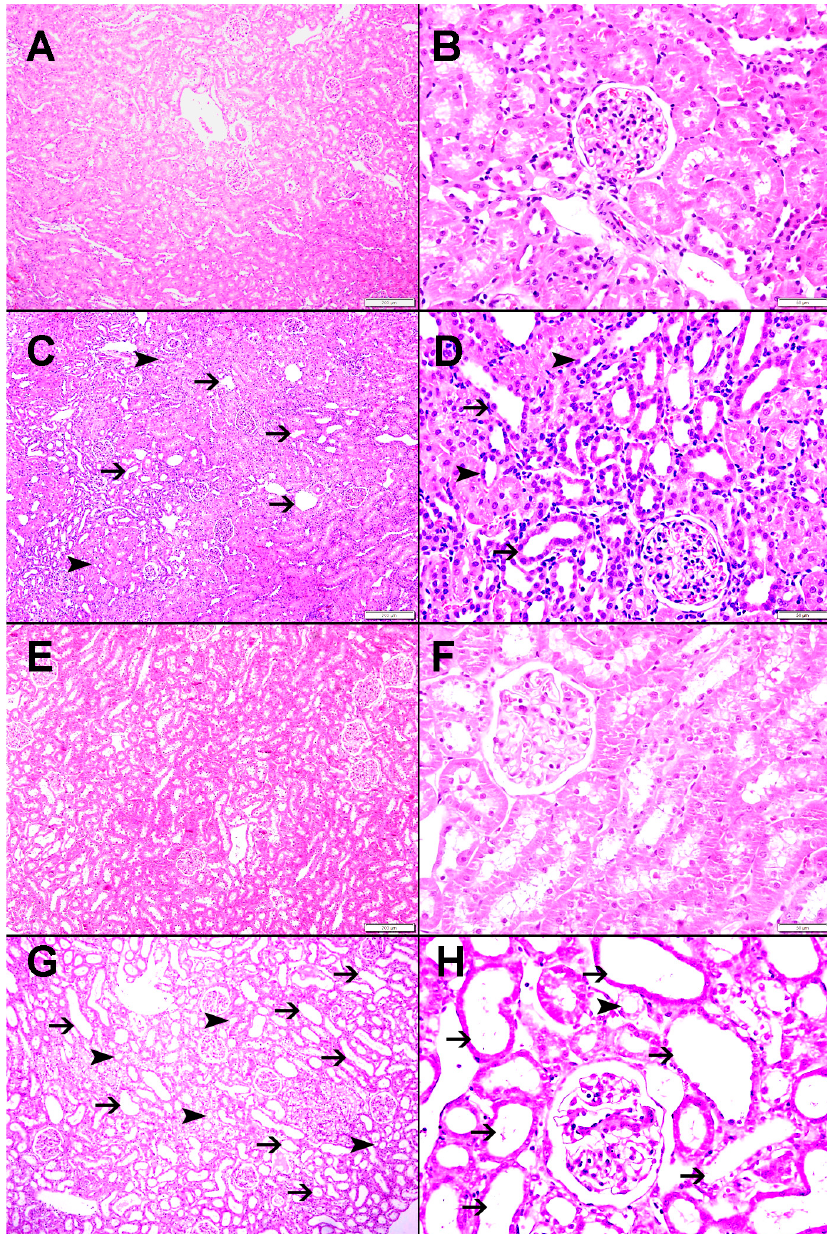
Figure 6. Histological features in the G ‐ NT and G ‐ HT groups. ( A , B ) the right NOK in the G ‐ NT showing normal kidney architecture and histology with no dilated tubules, tubular atrophy, inter ‐ stitial fibrosis, or interstitial mononuclear cellular infiltrate). ( C , D ) the left POK in the G ‐ NT, which shows focal areas of tubular dilatation (thin arrow), and tubular atrophy (arrowhead). ( E , F ) the right NOK in the G ‐ HT with normal kidney architecture and histology (no dilated tubules, tubular atro ‐ phy, interstitial fibrosis or interstitial mononuclear cellular infiltrate). ( G , H ) The left POK in the G ‐ NT shows focal areas of tubular dilatation (thin arrow) and tubular atrophy (arrowhead). The white bar at the bottom right corner of each sub ‐ figure represents a measurement scale. It measures 200 μ m in A, C, G and E and 50 μ m in B, D, F and H.